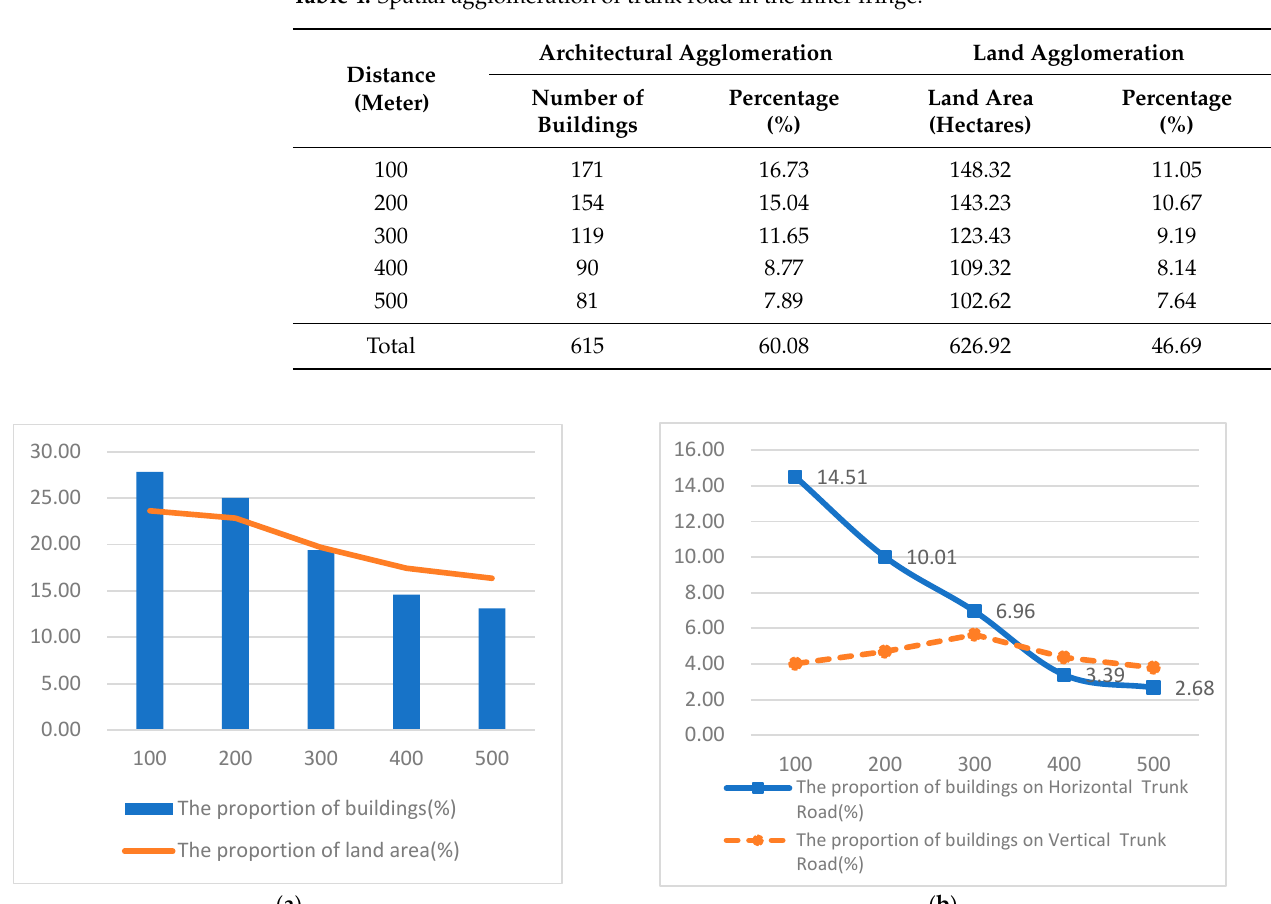
Figure 6. Spatial agglomeration of trunk road in the inner fringe: ( a ) both directions trunk road; ( b ) different directions trunk road .